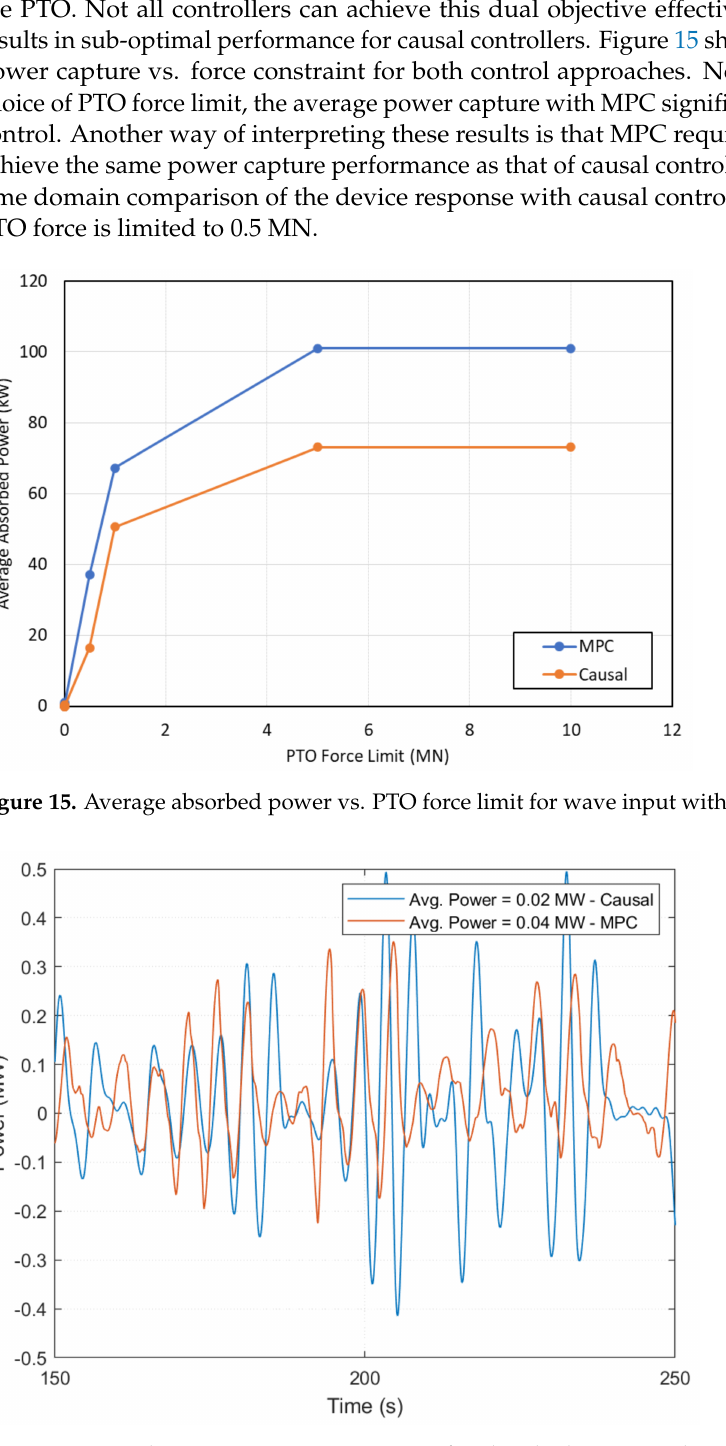
Figure 16. Time domain response comparison for absorbed power with PTO force limit = 0.5 MN. Significant wave height Hs = 1.0 m, peak period Tp = 16